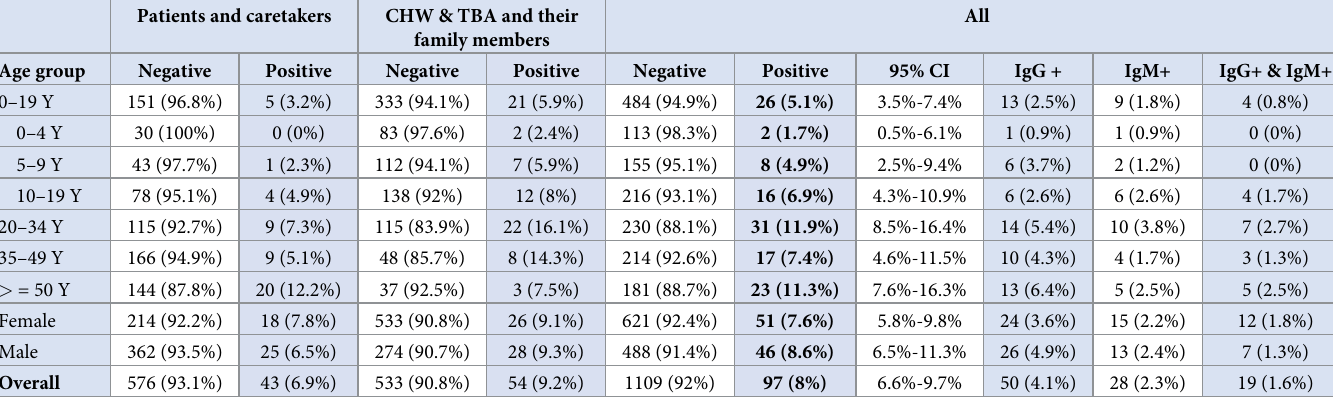
Table 1. Results of rapid diagnostic test by age group, by sex, and overall, Dagahaley refugee camp, Garisa County, Kenya, May 2021.